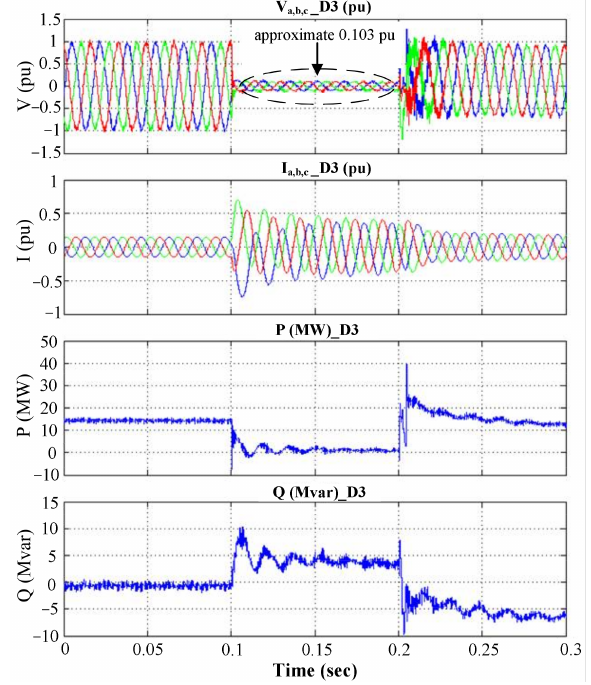
Figure 8. Responses of voltage, current, and real and reactive power on bus D3.